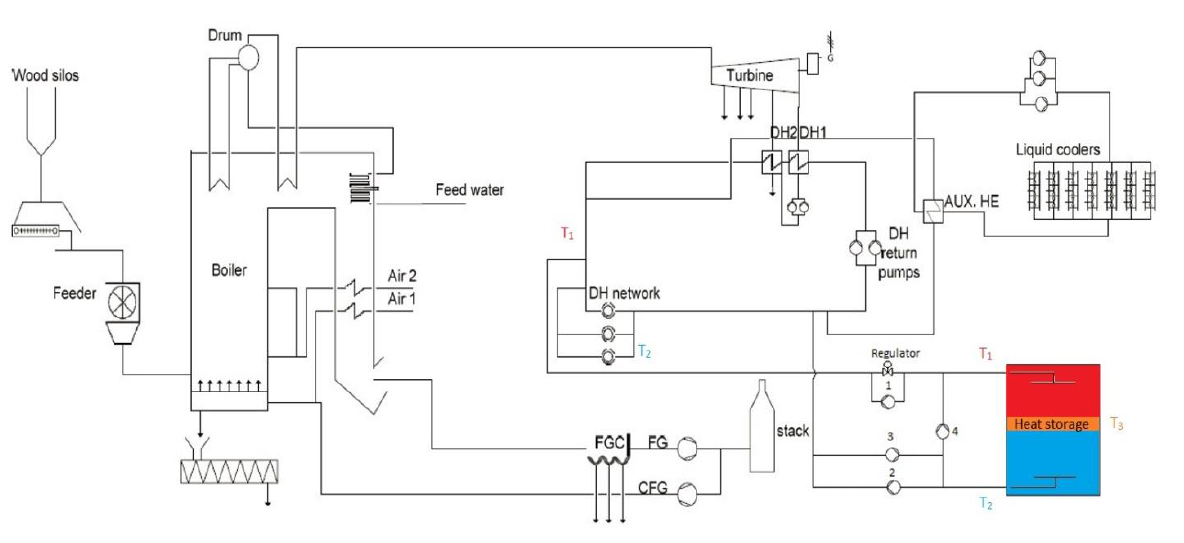
Figure 1. The Biomass cogeneration plant with a heat accumulator scheme is shown